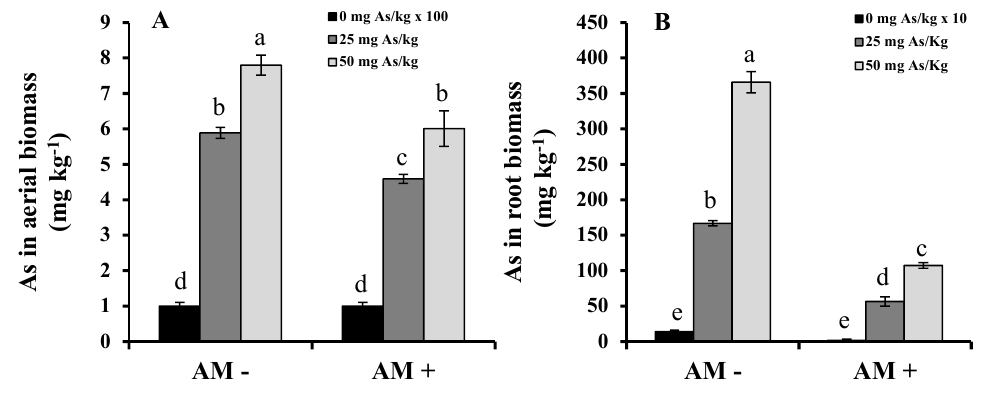
Figure 7. (A ) Arsenic concentration in soybean aerial biomass; ( B ) arsenic concentration in soybean root biomass. Letters indicate significant differences between treatments ( p < 0.05), as assessed by Tukey’s